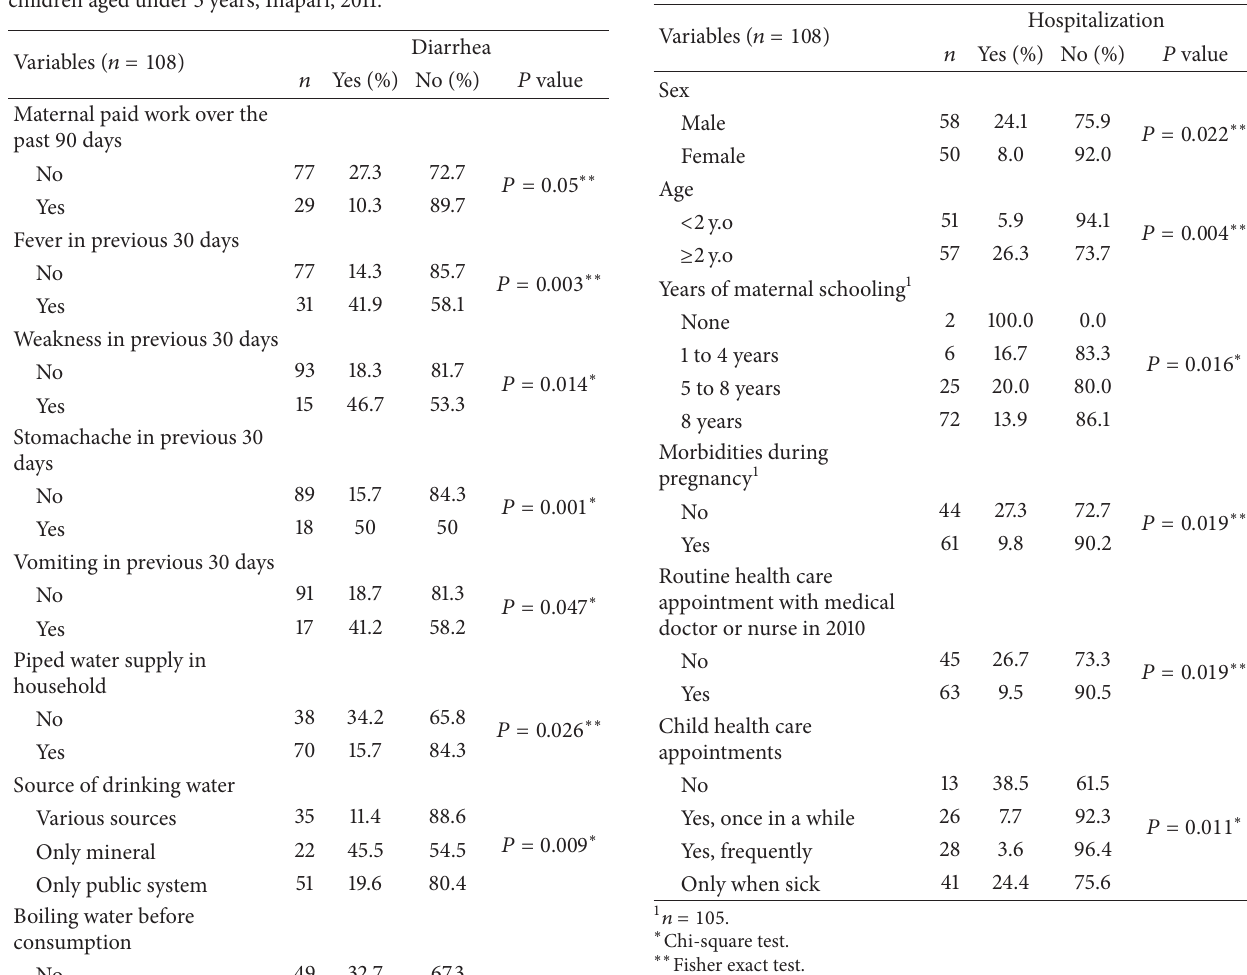
Table 8: Factors associated with